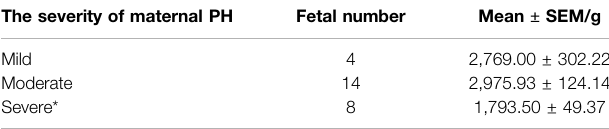
TABLE 4 | Mean fetal birth weight in each human maternal PH